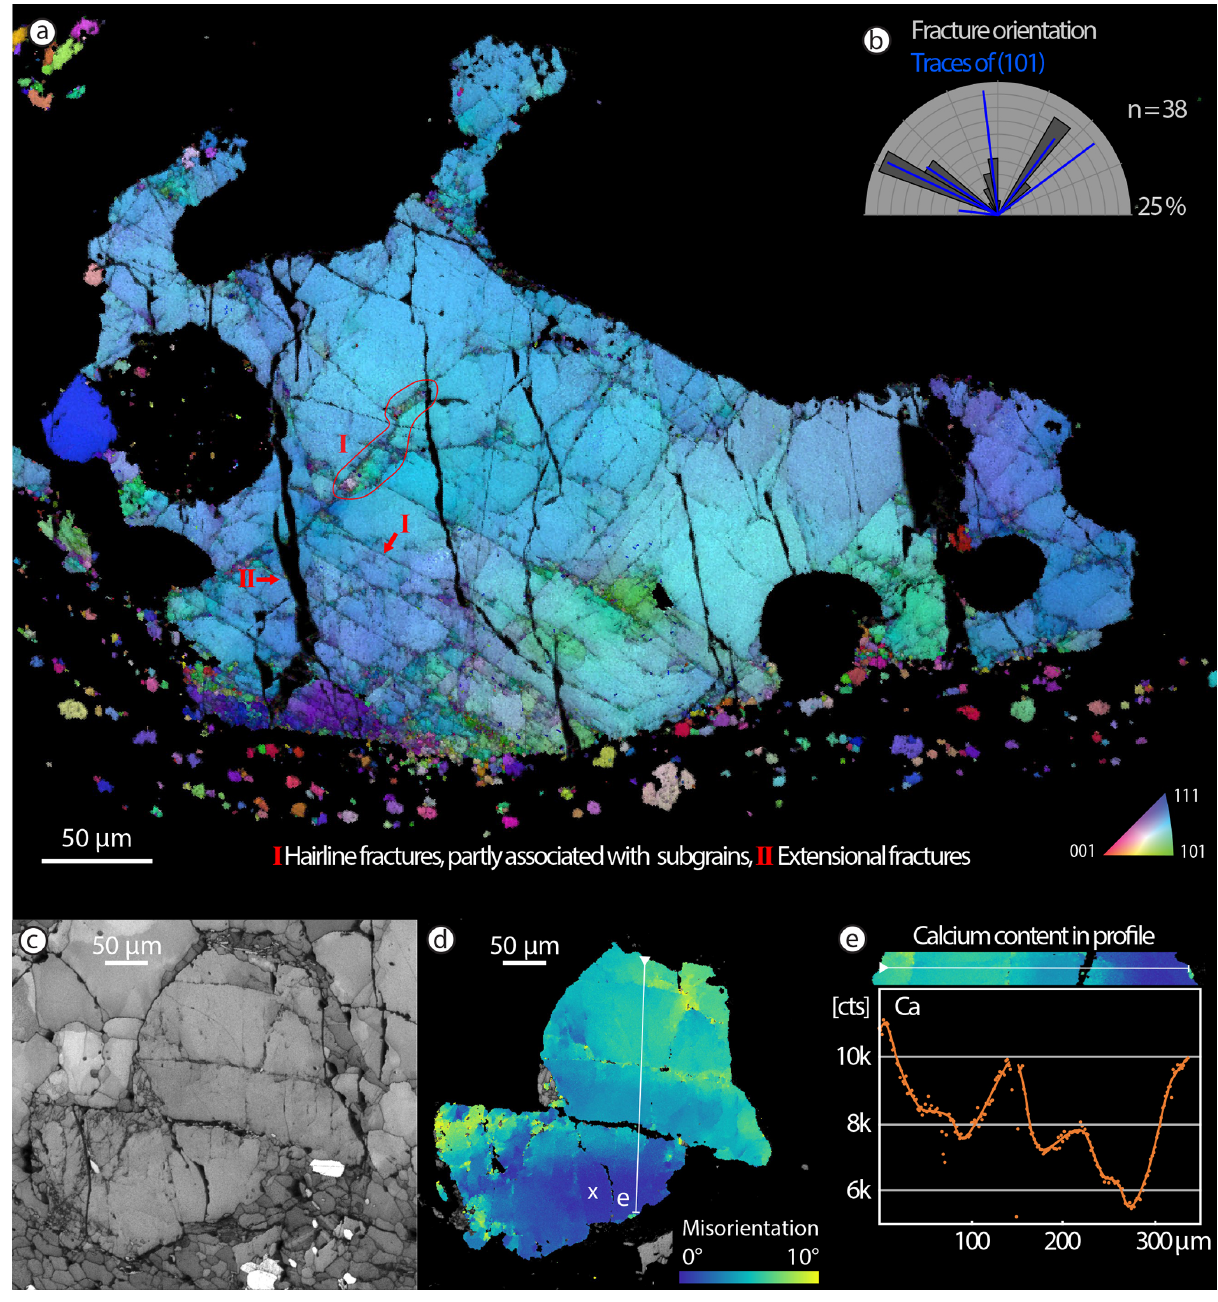
Figure 5. (a) An inverse pole figure map of fractured garnet with three dominant orientations of fractures. (b) A rose diagram correlating traced fracture orientations and (101) planes for garnet in (a) . (c) An image quality map of a fragmented garnet with subgrains. (d) A misorientation plot (with respect to the point marked with the white x ) shows long wavelength bending in the lower fragment and distortion in the crystal lattice induced by a fracture in the upper fragment. (e) EDS calcium counts for the profile marked as a thin white line in (d)